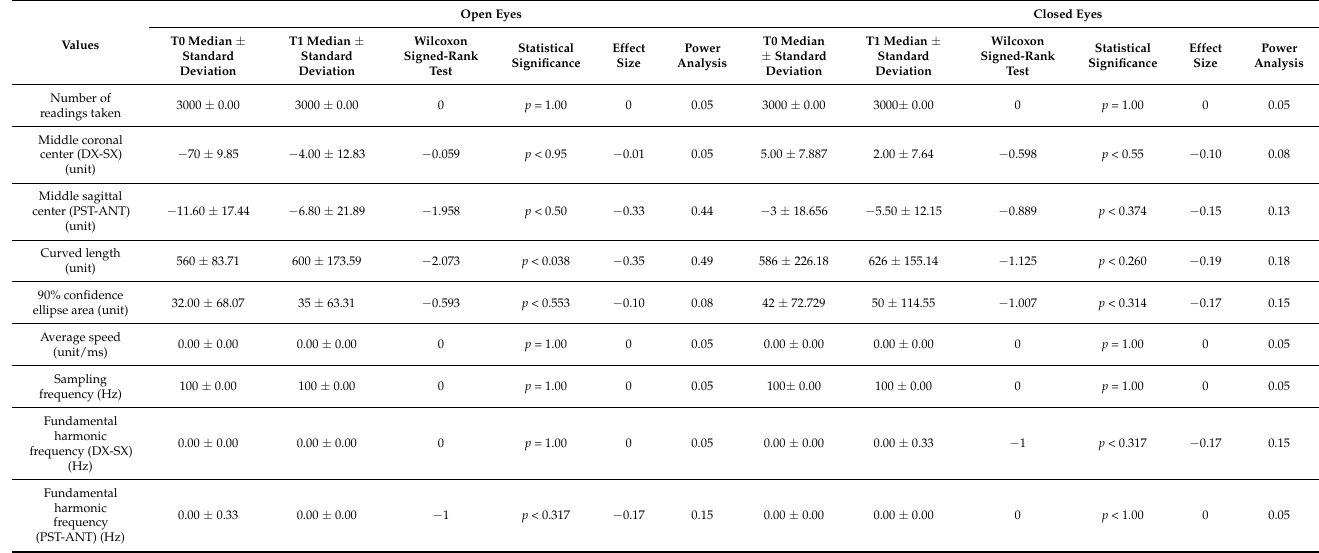
Table 3. Median at the beginning and after 10 sessions of equine therapy and calculation of the value of p for the stabilometric platform with open and closed